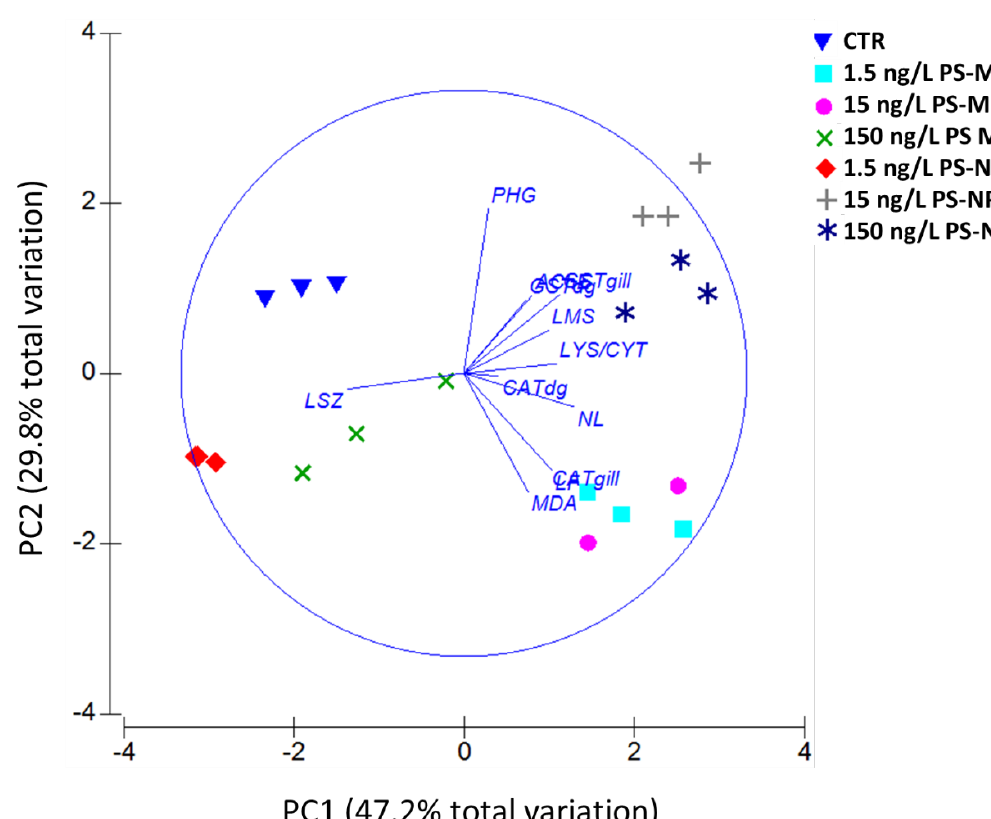
Figure 5. Principal component analysis (PCA). Biplot showing the PCA output including the entire set of biological data obtained in mussels exposed to increasing concentrations of PS-MP and PS-NP for 21 days.